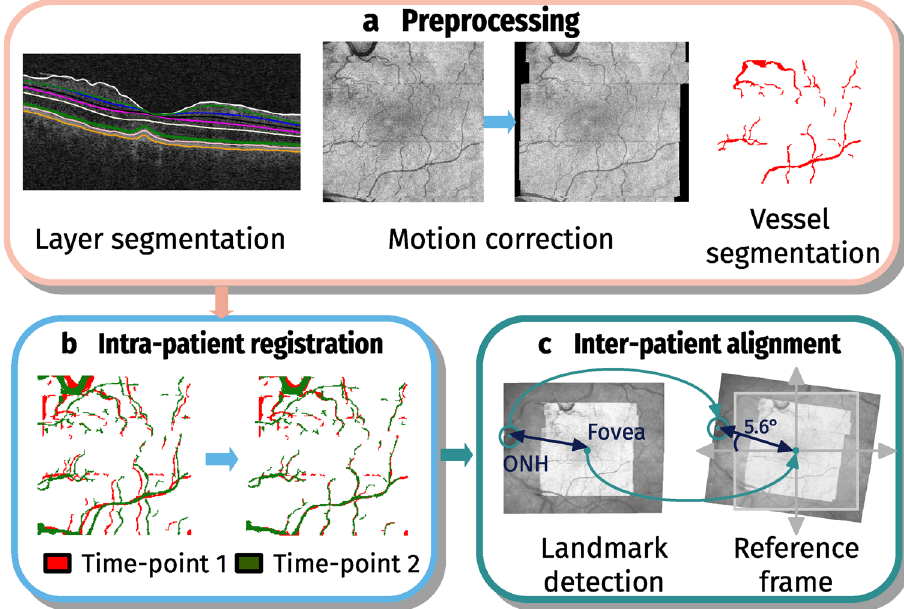
Figure 1. Steps to generate a reference frame by intra-patient and inter-patient alignment. ( a ) Preprocessing steps containing layer segmentation, correction of motion errors and segmentation of main vessels. ( b ) Intra- patient registration by aligning the vessel structure. ( c ) Inter-patient registration comprising optic nerve head (ONH) and fovea landmark detection in the SLO and SD-OCT image. The fovea position is moved to the centre of reference frame and the OCT is rotated such that the ONH centre is at the population mean